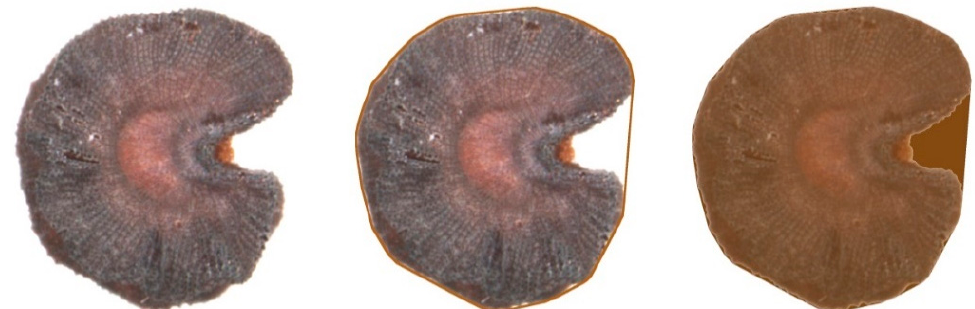
Figure A1. A seed of Silene apetala ( left ) with the corresponding convex hull ( center ). The image on the ( right ) shows the area of the convex hull corresponding to the seed image. Solidity is the ratio between the area of an object and the area of a convex hull of the same object. In the seed image of the figure, solidity equals 0.94. Solidity equals one in convex figures.